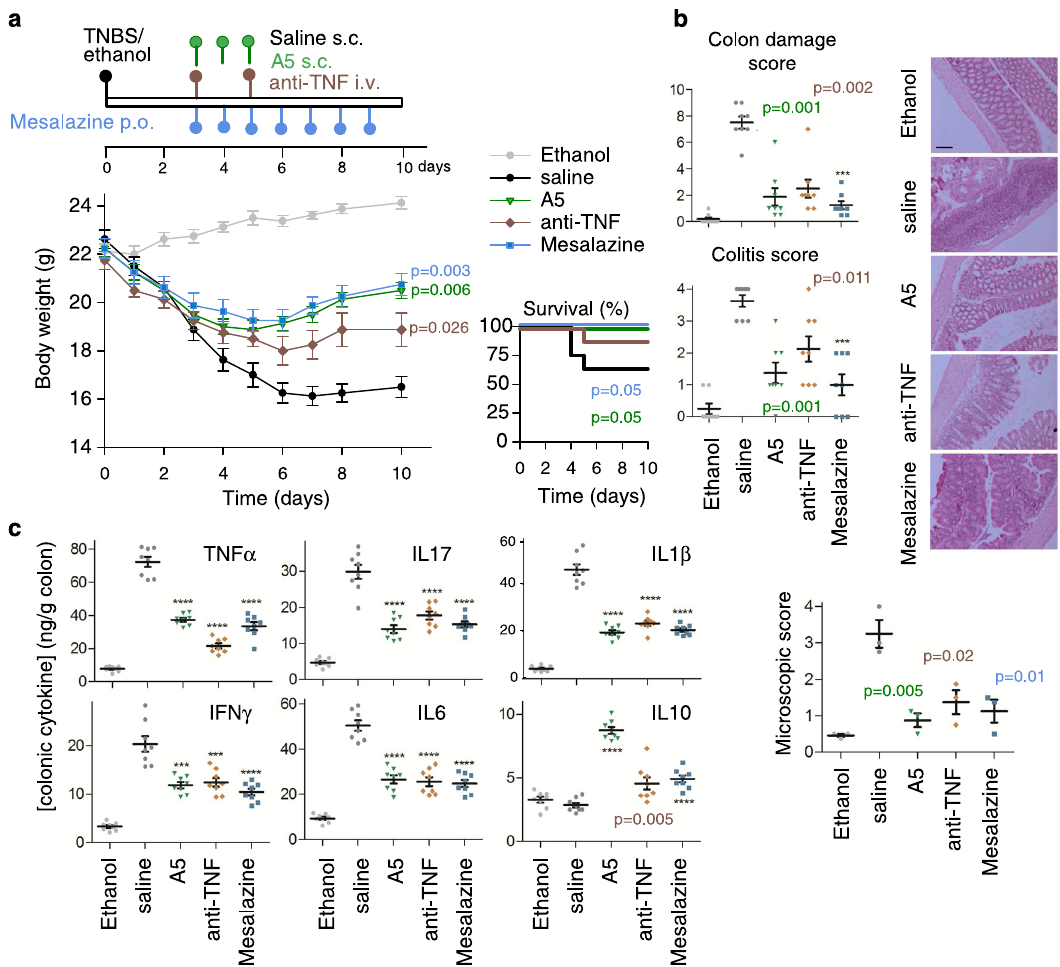
Fig. 4 Comparative therapeutic effects of analogue 5 with treatments of reference on TNBS-induced acute colitis. Acute colitis was induced in mice by intrarectal TNBS and the animals were then treated with analogue 5 (A5) or with treatments of reference (anti-TNF α antibody and Mesalazine) following the therapeutic regime indicated in the scheme ( a ). Mice injected intrarectally with 50% ethanol were used as basal controls. Animals injected with saline instead of A5 were used as untreated colitic mice. Disease evolution and severity were monitored by survival and weight loss, colitis score, macroscopic colon damage score and histopathological signs ( b ) and by measuring the cytokine levels in colonic mucosa ( c ). n = 8 mice/group in all assays, unless for histopathological analysis ( n = 3 mice/group, where representative images are shown at ×100 magni fi cation, scale bar: 200 µ m). Data are mean ± SEM with dots representing individual values of biologically independent animals. Statistical differences between groups were calculated using two-tailed non- parametric Mann – Whitney test (for colon damage, colitis and microscopic scores), unpaired two-tailed Student ’ s t test (for body weight and colonic cytokines) and Kaplan – Meier test (for survival). *** p < 0.001; **** p < 0.0001 versus untreated TNBS-colitic mice (saline). Exact p -values are shown for p > 0.001. Source data are provided as a Source Data fi le. s.c. subcutaneous, i.v. intravenous, p.o.